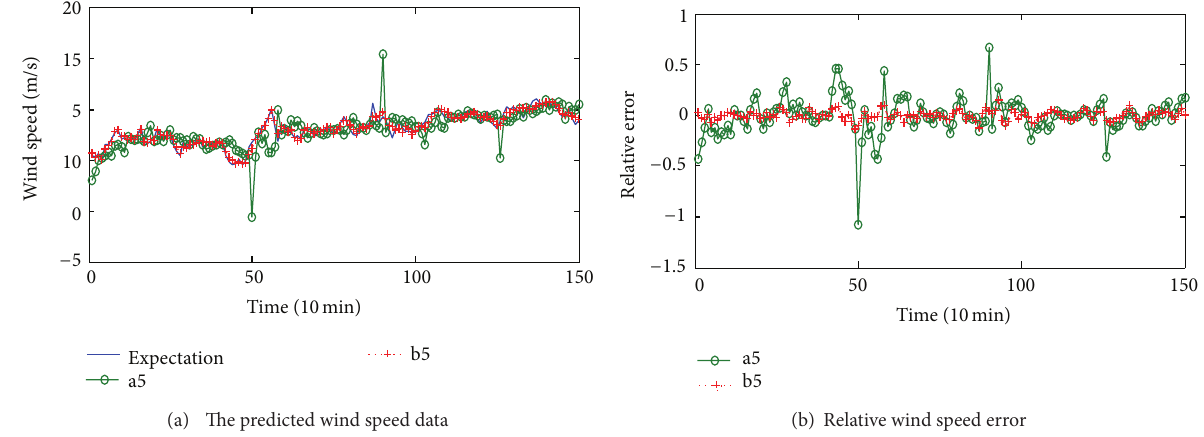
Figure 5: The effect comparison between a5 and b5.